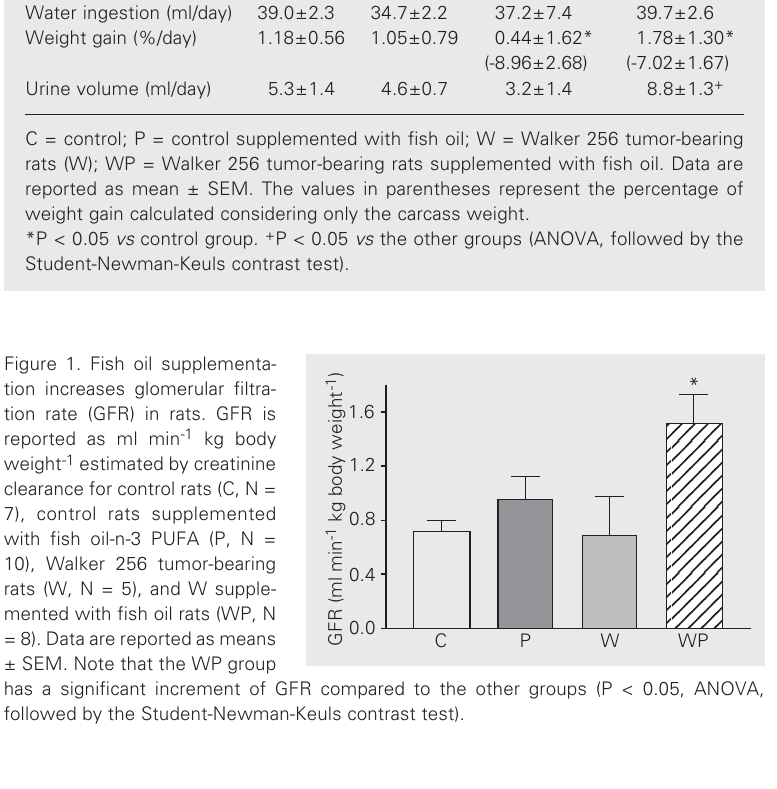
Table 1. Effect of chronic fish oil supplementation on daily food consumption, water ingestion, weight gain, and urinary volume of the groups studied. C (N = 10) P (N = 9) W (N = 6) WP (N = 8) Food consumption (g/day) 25.3±1.07 Water ingestion (ml/day) 39.0±2.3